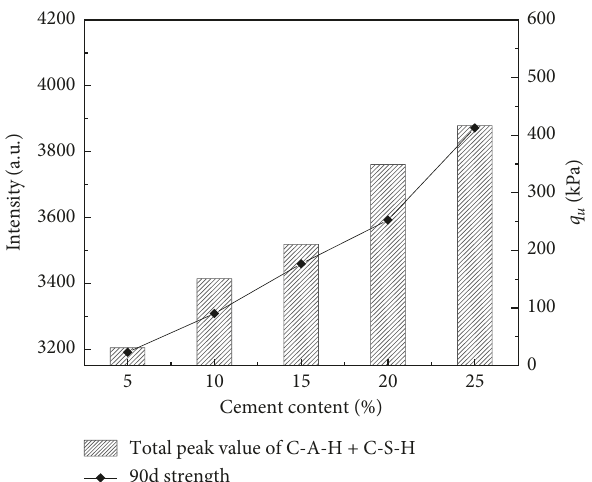
Figure 11: Relationship between the diffraction peak of C-A- H+C-S-H and strength of cement soil and cement ratio.